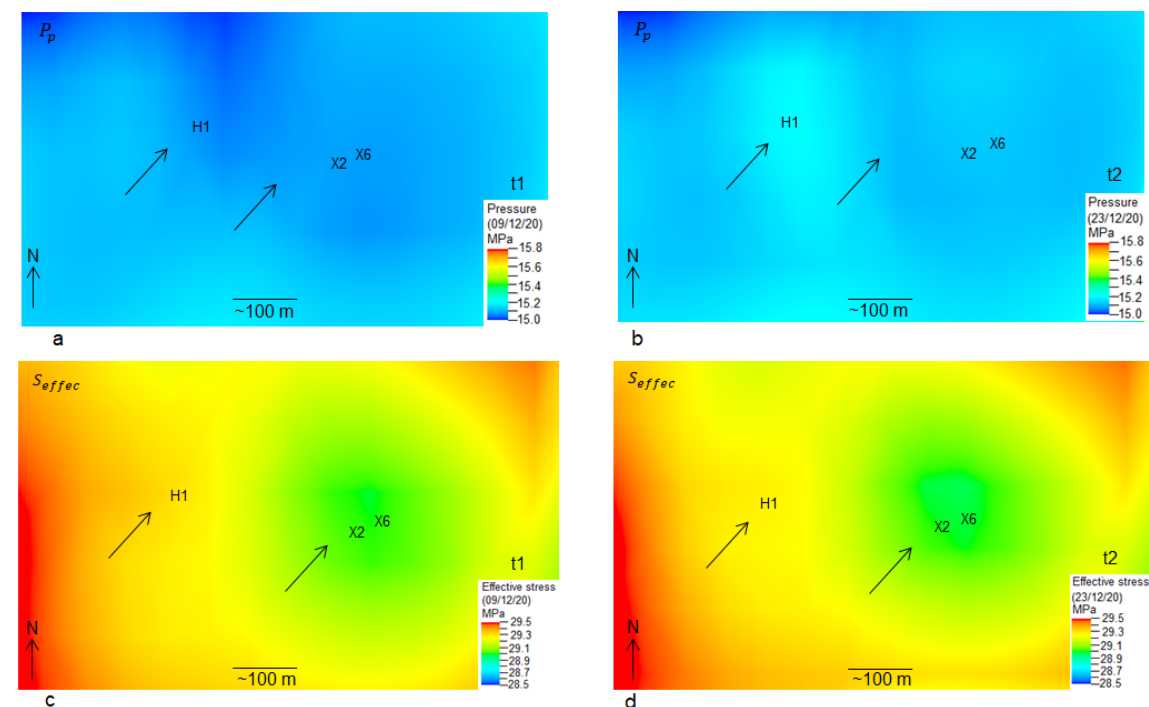
Figure 4. Pore pressure ( P p ) and effective stress ( S ef fec ) changes from t1 (16 December 2020) to t2 (23 December 2020) in the short-term case with three wells (X2, X6, and H1) with a water cut-off rate of 5 m 3 /day. The arrows show the location of maximum observed fluctuations in P p and S ef fec from t1 to t2. The color scale is in MPa. ( a ) is pore pressure at time t1; ( b ) is pore pressure at time t2; ( c ) is effective stress at time t1; ( d ) is effective stress at time